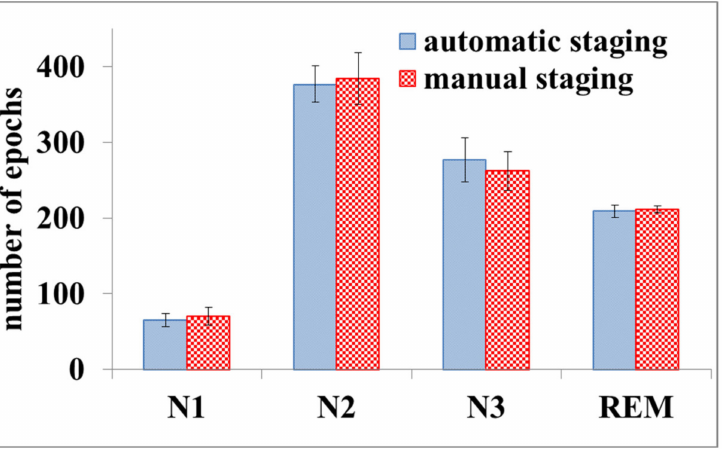
Figure 7. Results of automatic sleep staging and manual staging. The error bars represent the standard